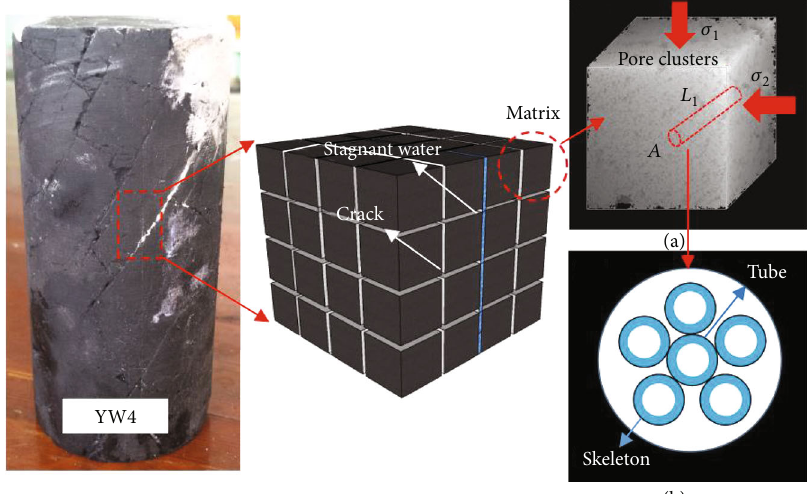
Figure 6: The Warren-Root model of coal: (a) pore clusters in porous matrix; (b) seepage model of pores comprising capillary tubes and